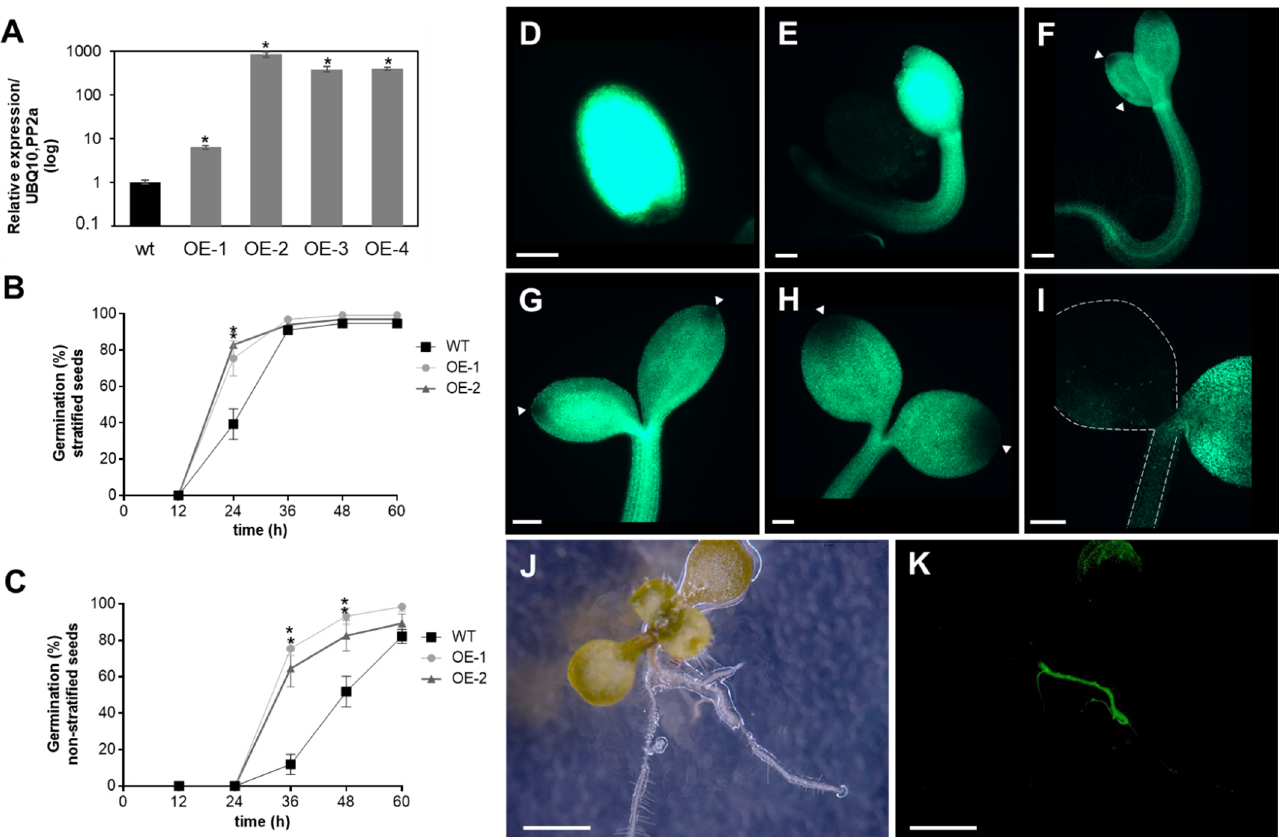
Figure 4. Analysis of AtAPx-R-YFP overexpressing plants. ( A ) Relative expression of AtAPx-R-YFP OE lines. Two-week- old seedlings from wild-type Col-0 and four independent transgenic lines were analyzed by RT-qPCR. Gene expression analysis was normalized by two reference genes: PP2A (At1g13320) and UBQ10 (At4g05320). Each time point consisted of three biological replicates ( n = 5) and four technical replicates. ( B ) Time-course germination of stratified and ( C ) non- stratified seeds of two representative AtAPx-R-YFP OE lines and wild-type Col-0. Each time point consisted of three bio- logical replicates ( n = 45). Two independent experiments were performed. ( D – I ) Seeds from AtAPx-R-YFP OE-2 line were germinated in light and analyzed throughout early stages of plant development. Arrowheads indicate early loss of APx- R-YFP fluorescence. Dashed lines were added for plant outlines determination. ( J , K ) Representative 10-days-old plant from AtAPx-R-YFP OE-1 line analyzed under a stereomicroscope. (J) Bright field; and ( D – I , K ) YFP fluorescence. * Signif- icant difference according to Student’s t-test ( p < 0.05). Scale ( D ) 400 µm; ( E – I ) 200 µm; and ( J , K ) 1 mm.